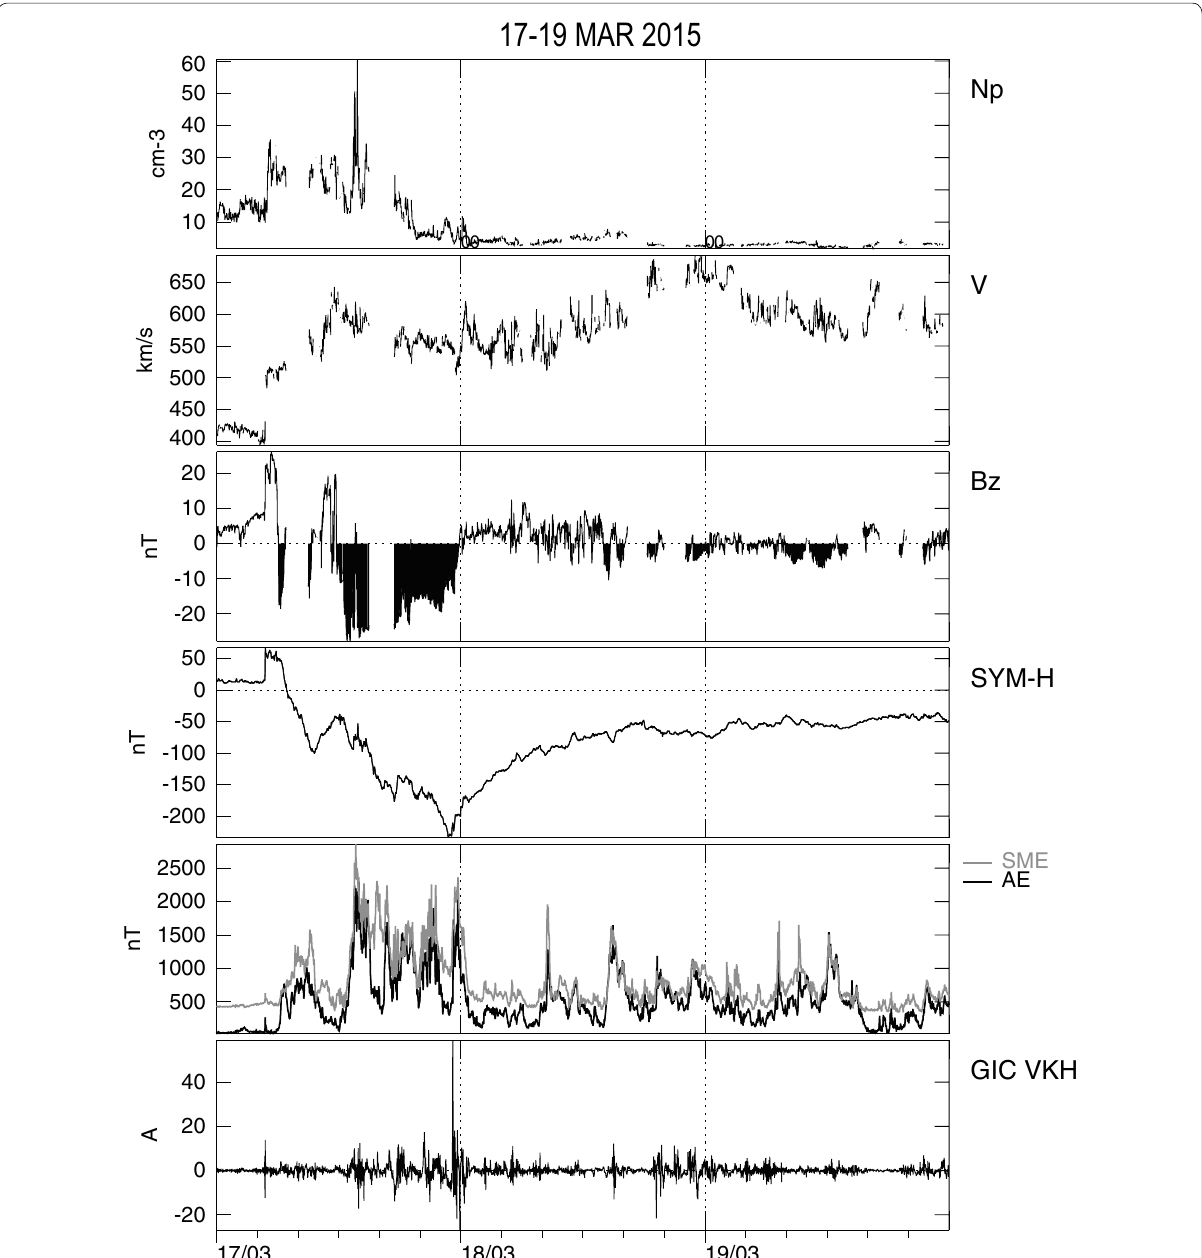
Fig. 1 Space weather parameters during the March 17–19, 2015, storm: the solar wind density Np and velocity V , IMF Bz , SYM-H ring current index, AE and SME auroral indices, and GIC intensity (in Amperes) at station